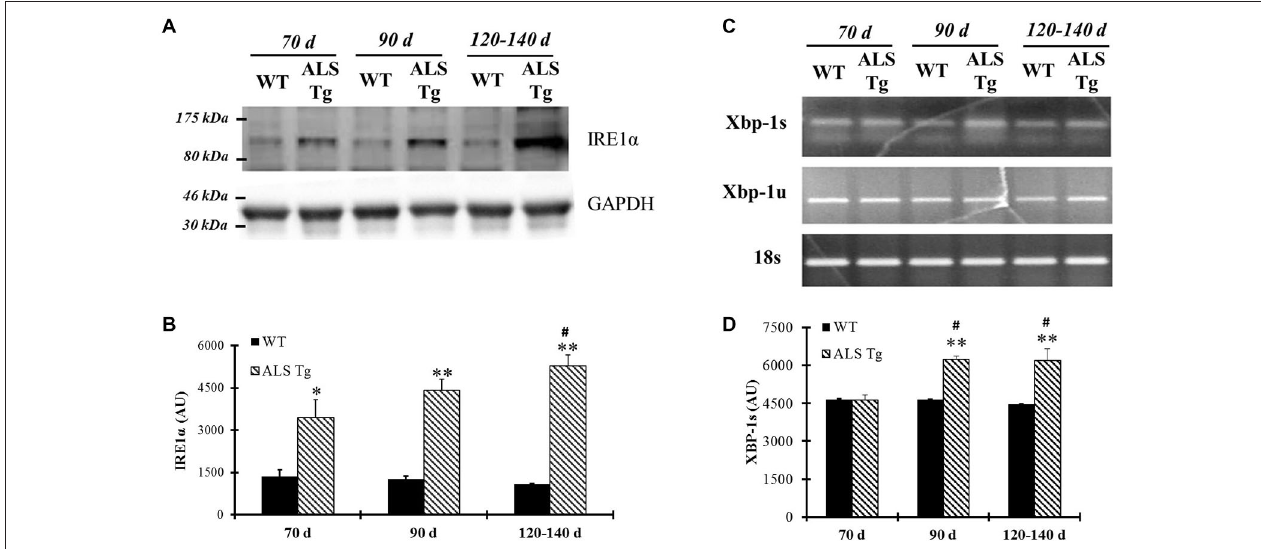
units (AU) obtained by densitometry for IRE1 α . (C) Total mRNA was isolated by using Tibialis anterior (TA) muscle tissues and un-spliced (Xbp-1u) and spliced Xbp-1 (Xbp-1s) transcriptional levels were determined by using semi-quantitative PCR and PCR results are shown by running the products in 1.5% agarose gel. 18S was used as the internal control. Three different ages animals as mentioned previously were used. (D) Analysis of average arbitrary units (AU) obtained by densitometry for Xbp-1s. Data in (B,D) are presented as mean ± S.E; *, p < 0.05; **, p < 0.01 WT vs. ALS-Tg in the same age group. # p < 0.05 vs. 70d.